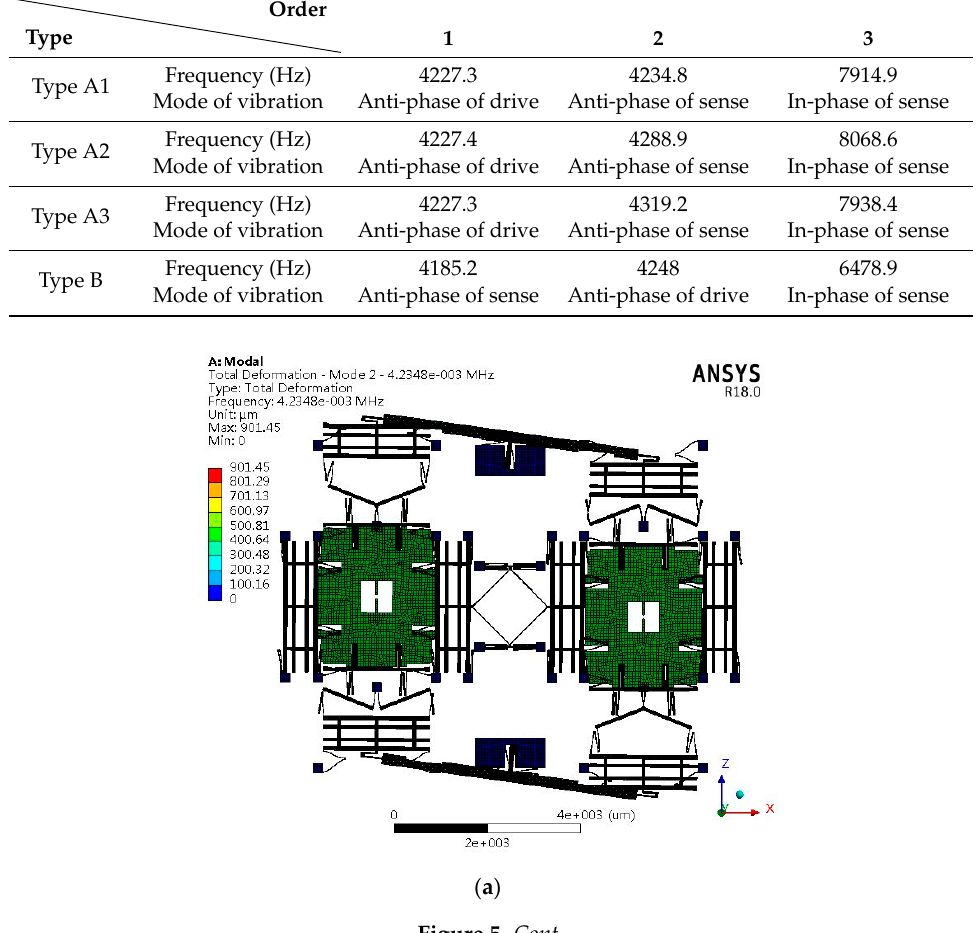
( b ) Figure 5. Anti-phase mode frequency in the sense direction of ( a ) type A1 and ( b ) type B. It can be seen from Table 3 that the anti-sense and anti-drive modes of all types are the first two order modes. The mode order of type A with an anchored leverage mechanism does not change compared to type B. The leverage mechanism can improve the frequency of in-phase sense mode, which can decrease the influence of the common vibration on the mechanical sensitivity. 4.2.2. Sensitivity Analysis To analyze the vibration output response, a mode-based steady-state linear dynamic analysis is performed on the design by ANSYS software to predict the linear response of a structure subjected to continuous harmonic excitation. In this simulation, the parameters of the structure, material properties of silicon, mesh division and element type are the same as those of the modal analysis. According to previous experimental results, the quality factor of MEMS gyroscopes is about 3000–8000 [33]. In this analysis, when the quality factor of type B is 4000, the quality factor of types A1, A2 and A3 can be calculated by the previous assumptions and defined as 6328, 6565 and 6605, respectively. In order to guarantee the accuracy and efficiency of the simulation, the frequency ranges of types A1 and B designs sweep from 4100 Hz to 4300 Hz based on the results of modal analysis in the previous section.